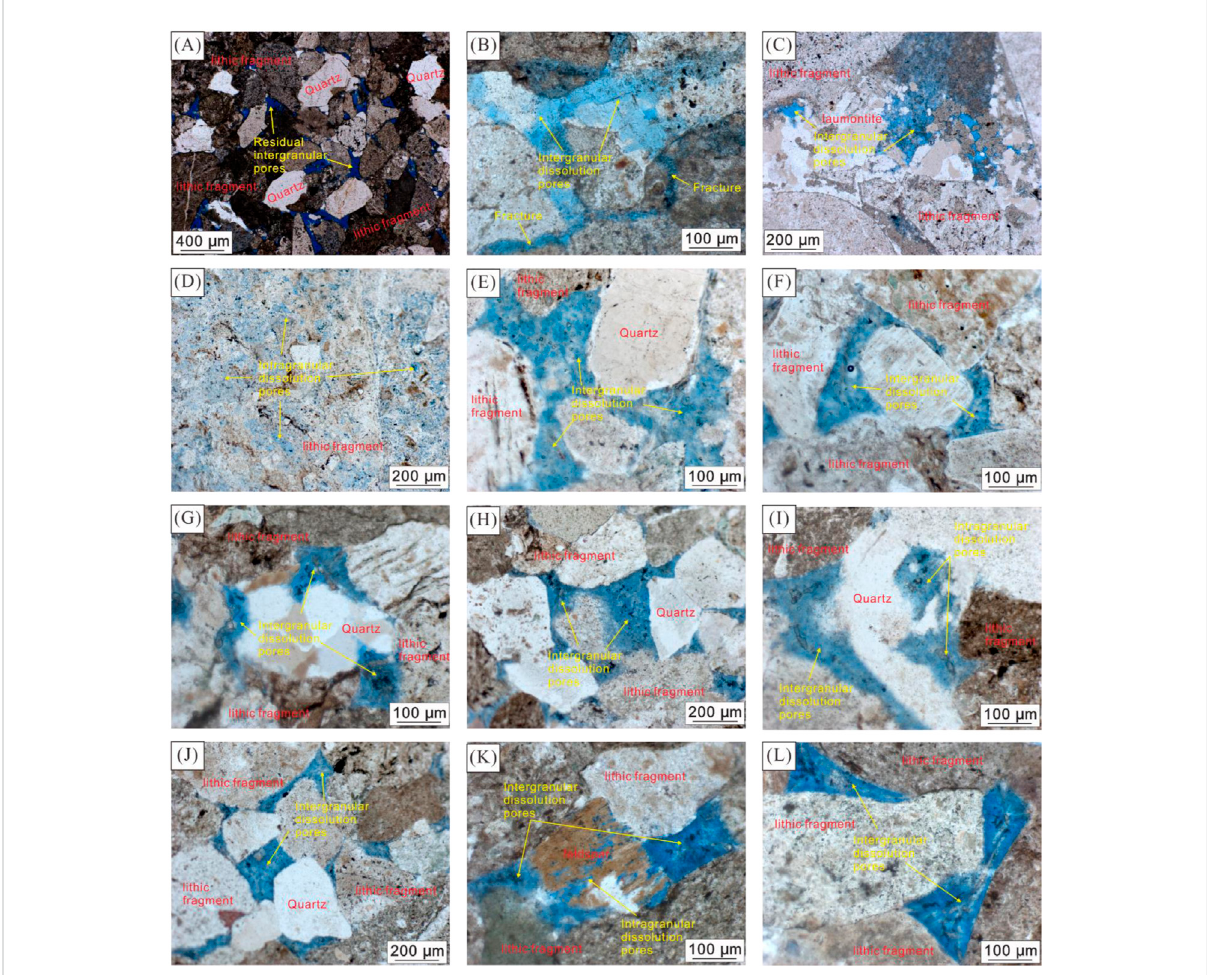
FIGURE 6 Pore characteristicsof theP 3 w reservoir inFukangSag under thethinsection (A) Well Fu43, 3136.7 m, P 3 w,and residual intergranular pores; (B) Well KT5, 5944.00 m, P 3 w, and intergranular pores formed by dissolution of lithic fragments and cement; (C) Well Fu50, 4289.81 m, P 3 w, and intergranular pores formed by cement dissolution; (D) Well Fu50, 4292.81 m, P 3 w, and intragranular microporosity formed by dissolution of lithic fragments; (E) Well Fu48, 4541.47 m, P 3 w, and intergranular pores formed by cement dissolution; (F) Well Fu48, 4541.47 m, P 3 w, and intergranularporesformedbycement dissolution; (G) Well Fu48, 4541.47 m,P 3 w,intergranularporeformedbydissolution ofpolycrystallinequartz, and lithic fragments; (H) Well Fu48, 4541.47 m, P 3 w, and intergranular pore formed by dissolution of lithic fragments; (I) Well Fu48, 4540.71 m, P 3 w, and intragranular pores formed by quartz dissolution; (J) Well Fu48 well, 4540.71 m, P 3 w, and intergranular pores formed by cement dissolution; (K) Well Fu48, 4538.76 m, P 3 w, intragranular and intergranular pores formed by dissolution of the feldspar and cement; and (L) Well Fu48, 4538.76 m, P 3 w, and intergranular pores formed by the cement